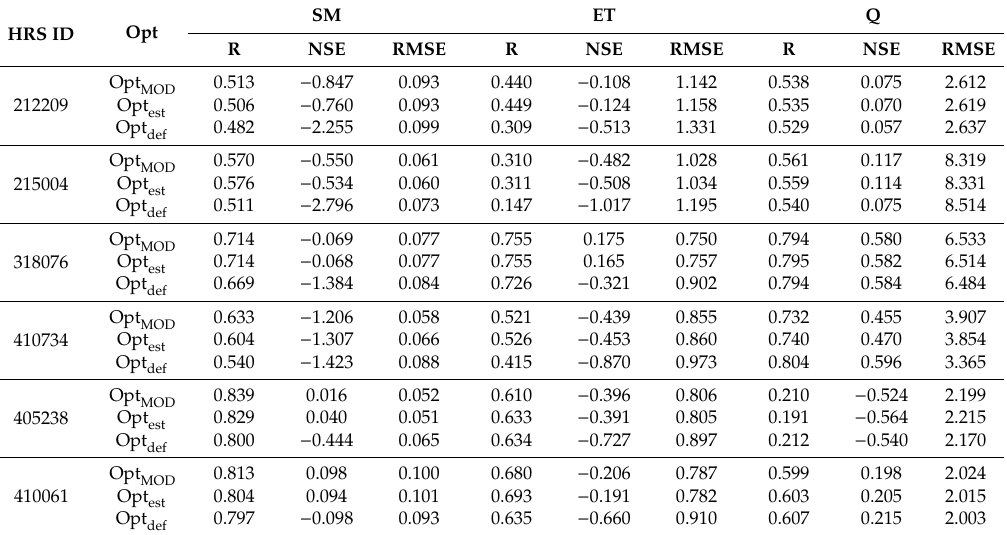
Table 6. Summary of SM, ET and Q Simulation Results over the Six